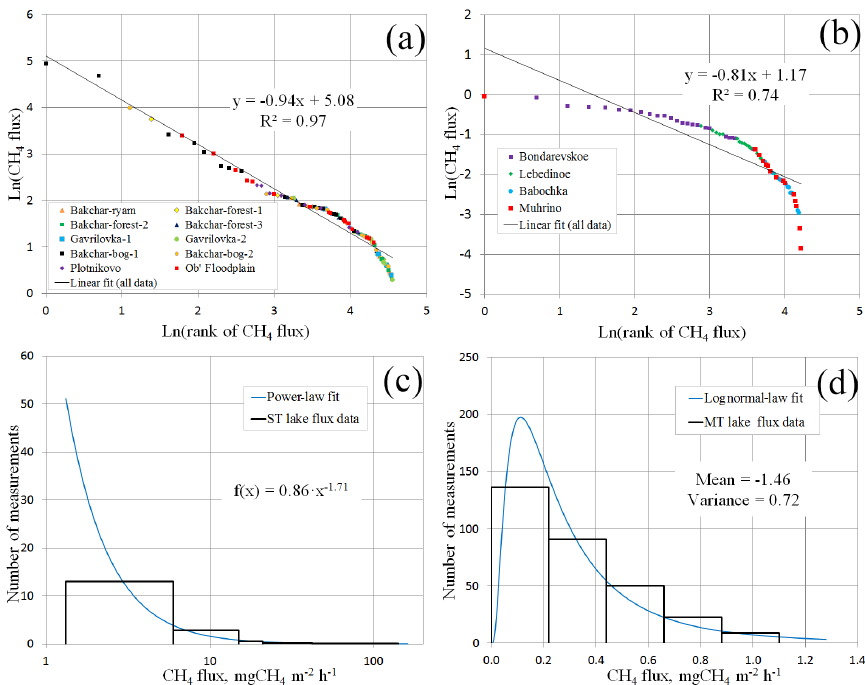
Figure 3. Flux data for (a) ST and (b) MT lakes on a log–log scale and probability distribution fitting: (c) power law for ST lake fluxes and (d) lognormal for MT lake fluxes. Rank 1 indicates the highest magnitude flux. Note the strong difference in the y axis scaling between the two regions.